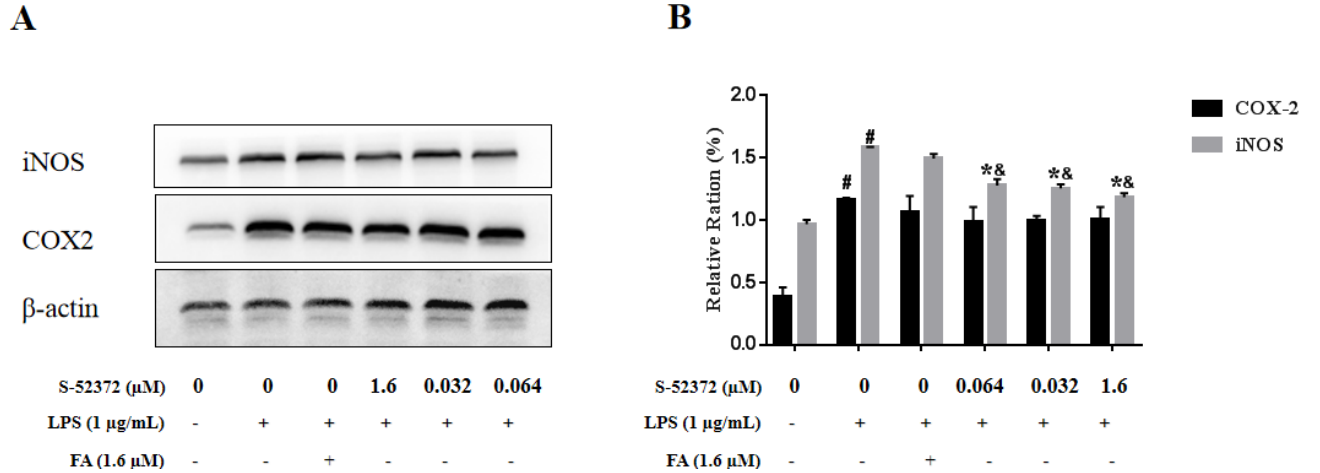
Figure 8. Ferulic acid and S-52372 decreased LPS − induced protein expressions of iNOS and COX-2. The protein expression of iNOS and COX-2 was detected by Western blot analysis. ( A ) iNOS and COX-2 protein expression levels. ( B ) Relative ration analysis. In addition to an untreated control sample, RAW264.7 cells were pretreated with 1.6 μ mol/L of FA as a positive control to compare with RAW264.7 cells pretreated with with S-52372 at 1.6, 0.32, and 0.064 μ M for 1.5 h, and then all groups were treated with 1 μ g/mL of LPS, except the control group, at 37 °C for 24 h. Each bar represents the mean ± standard deviation (SD) calculated from three independent experiments. * p < 0.05 compared to the only LPS − treated group; # p < 0.05 compared to the control group; & p < 0.05 compared to the FA group.